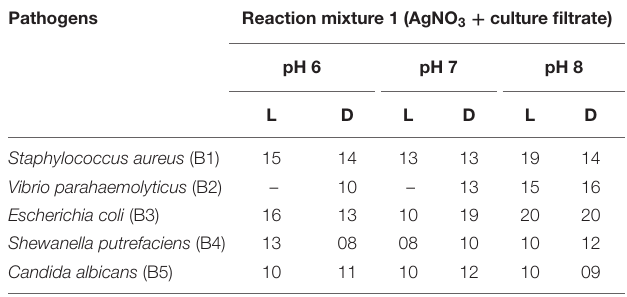
TABLE 3A | Antimicrobial activity of cultured filtrate and different light condition-mediated biosynthesized AgNPs. Pathogens